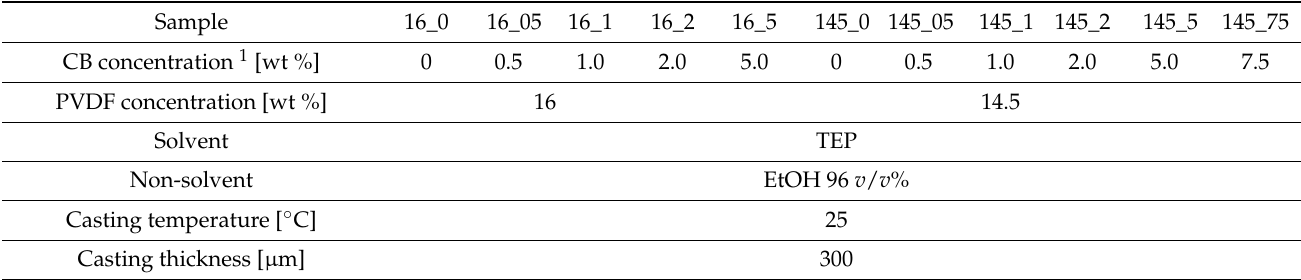
Table 1. Preparation conditions of the tested